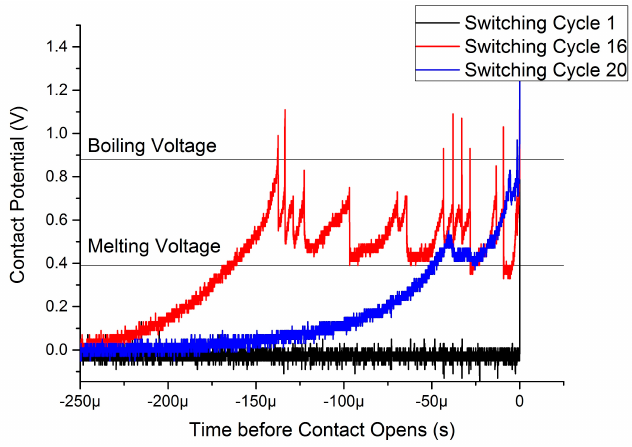
Figure 11. Contact Potential immediately before contact opening showing MMB and delamination type openings.